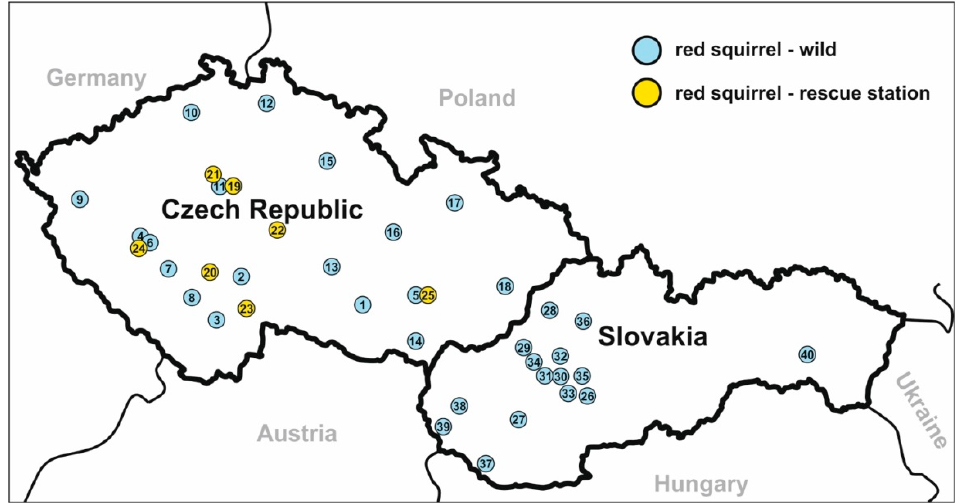
Figure 1. Sampling localities in the Czech Republic and Slovakia: For each site, the number